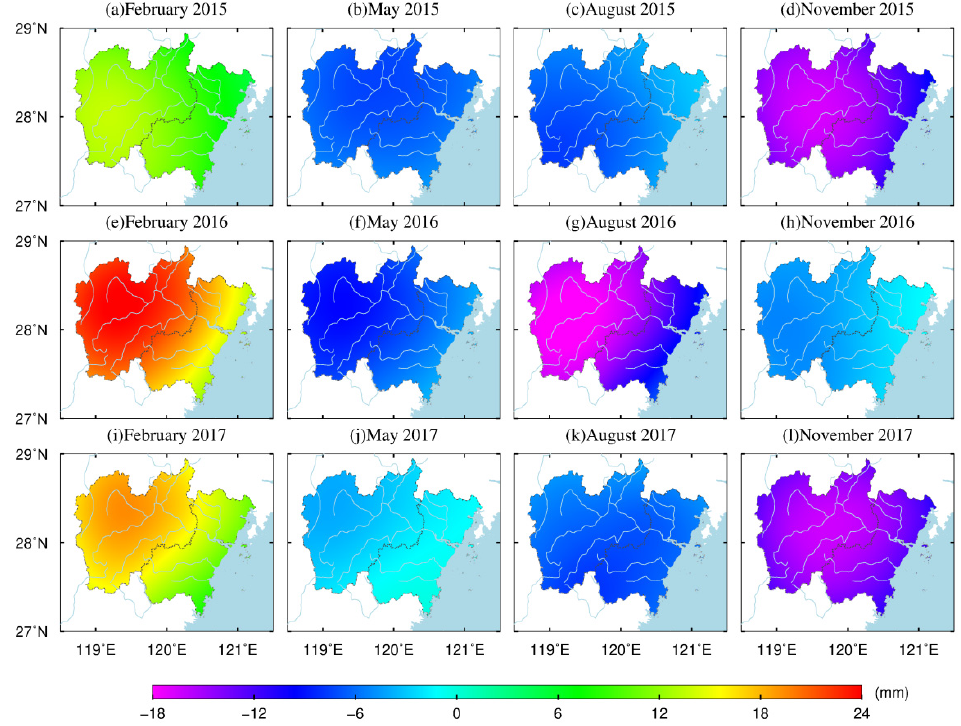
Figure 7. The spatial vertical deformation driven by the change in terrestrial water load from 2015 to 2017.